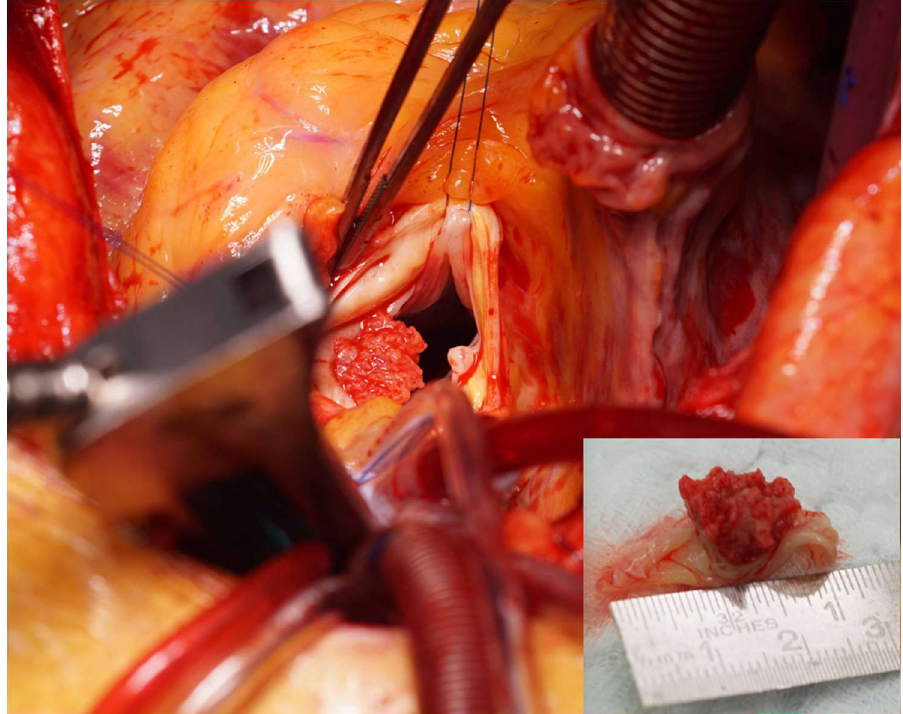
Figure 3. Intraoperative view. Intraoperative view showing a large vegetation on the aortic valve and close-up of the excised leaflet (inset). Two leaflets fused to form a functionally bicuspid valve.